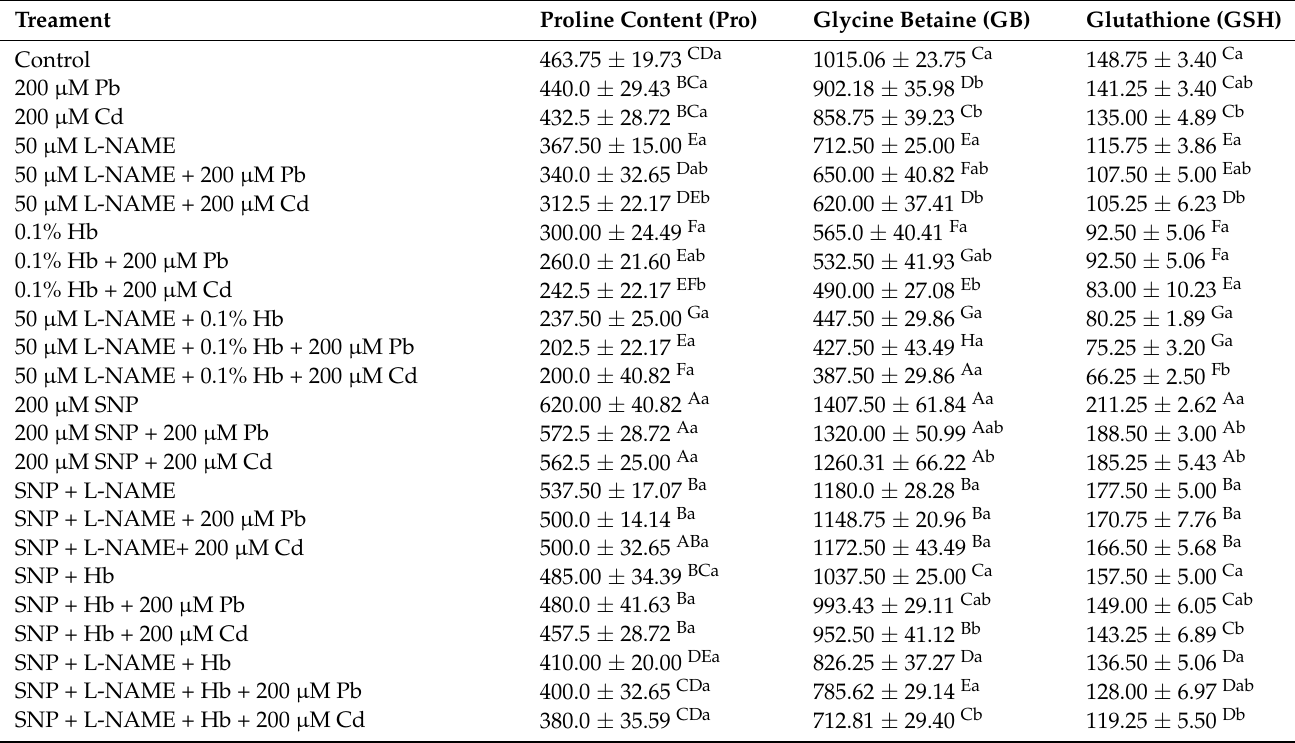
Each data point is the mean ± SE of four replicates. The treatments contained levels of nitric oxide (L-NAME, N(G)-nitro-L-arginine methyl ester (NO synthase inhibitor); 0.1% Hb, bovine hemoglobin (NO scavenger), and NO donor, sodium nitroprusside (SNP) alone and in combination with each other, as well as in combination with 200 µ M Pb and 200 µ M Cd. The capital letters indicated statistically significant differences across various levels of nitric oxide alone or in combination with 200 µ M Pb and 200 µ M Cd, while the lowercase letters displayed statistically significant differences within each level of nitric oxide alone and in combination with 200 µ M Pb and 200 µ M Cd, based on Tukey (cid:48) s test ( p < 0.05). They are superscripted on top of the